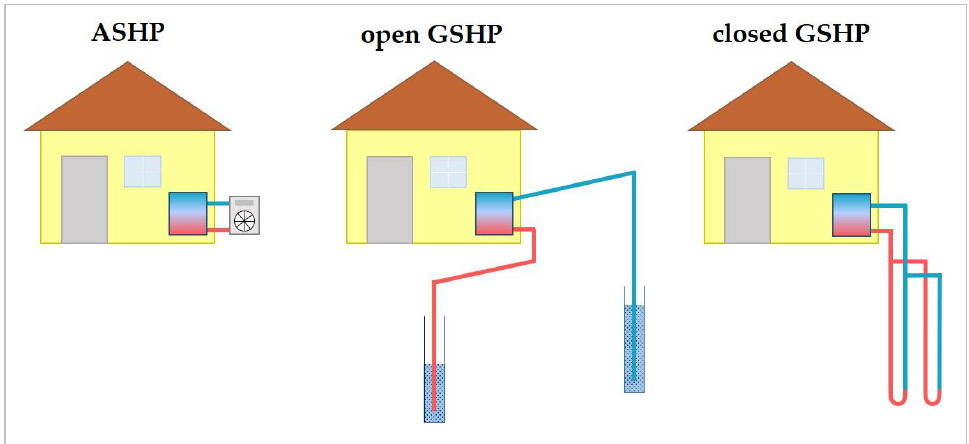
Figure 1. Main classification of heat pump systems by source (ASHP: air source heat pump; GSHP: ground-source heat pump).